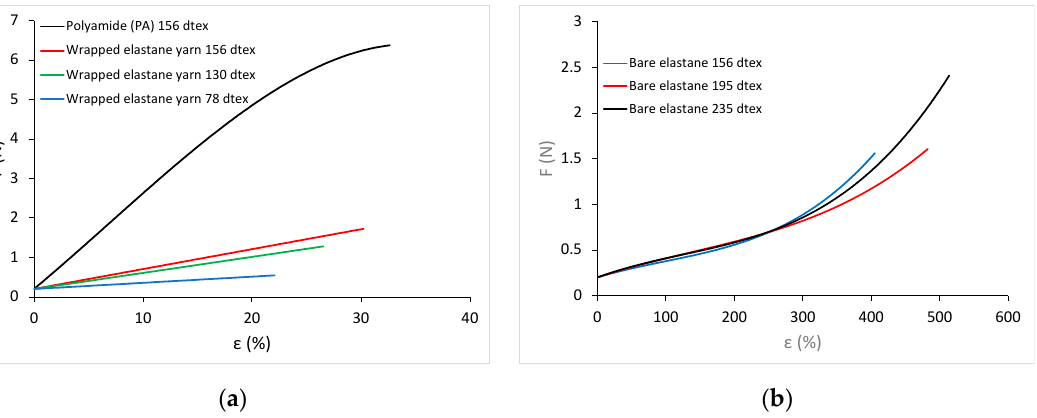
Figure 4. Force–elongation diagrams: ( a ) polyamide yarn and wrapped elastane yarn; ( b ) bare elastane yarn.